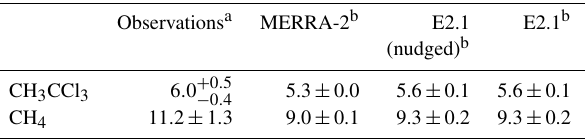
Table 5. Lifetime against oxidation by tropospheric OH (years). Observations